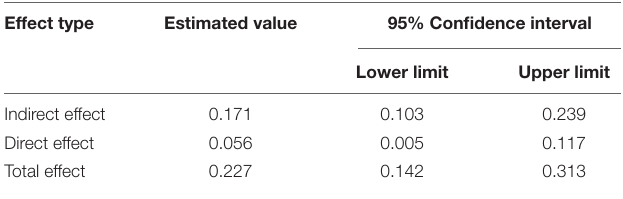
TABLE 5 | Mediation effect